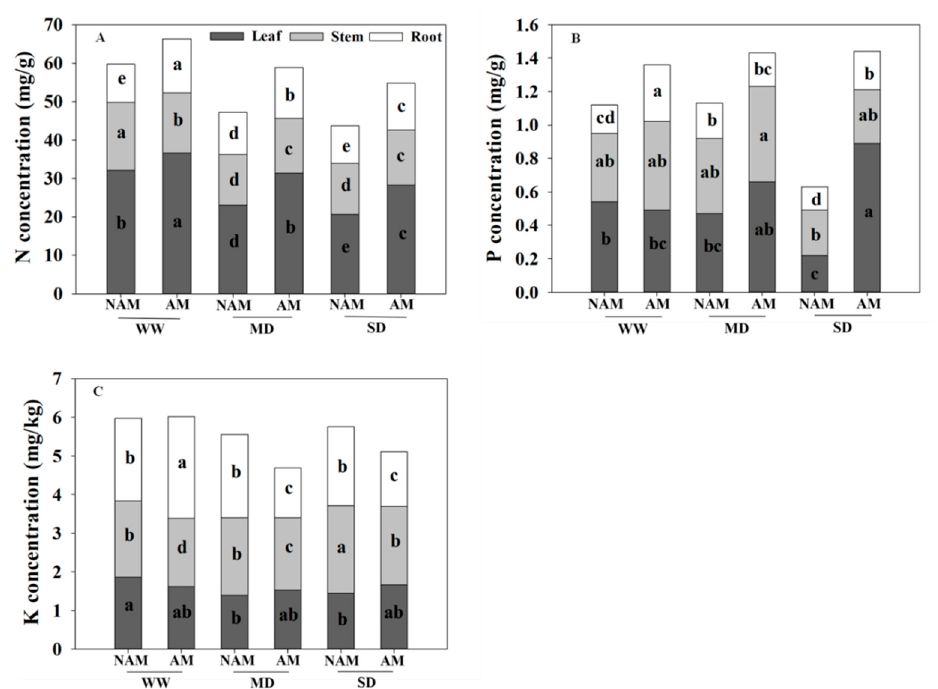
Figure 7. Effect of the arbuscular mycorrhizal fungus (AMF) Rhizophagus intraradices on the ( A ) nitrogen (N), ( B ) phosphorus (P) and ( C ) potassium (K) concentrations in Catalpa bungei seedlings under drought stress. NAM, non-AMF-inoculated; AM, AMF-inoculated; WW, well-watered; MD, moderate drought; SD, severe drought. Different lowercase letters above the bars indicate significant differences ( p < 0.05) among treatments. Values are means ± SE ( n = 3).